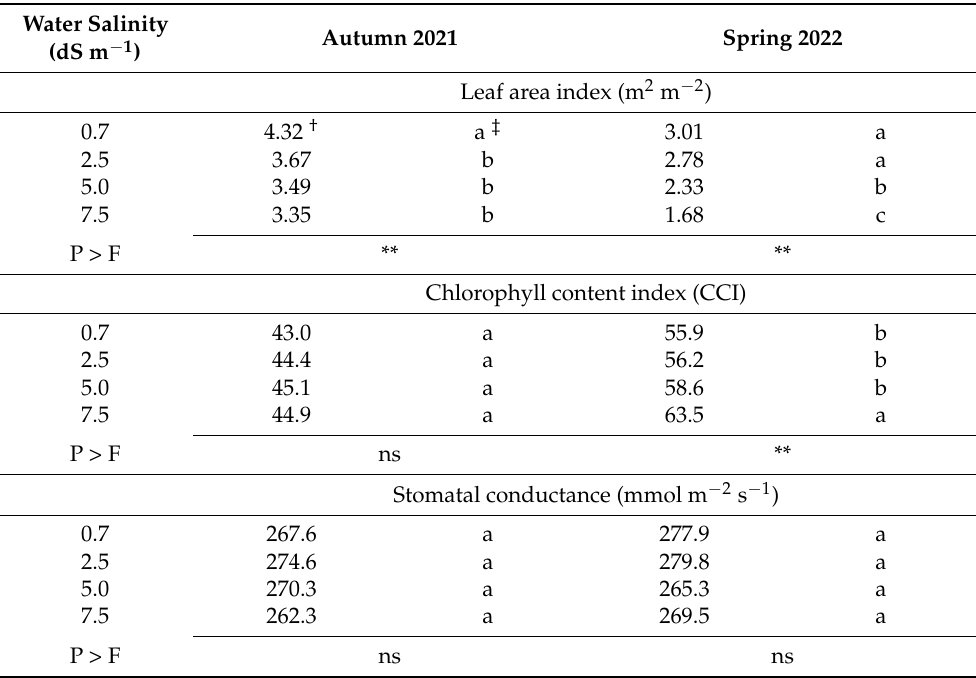
Table 5. The effect of irrigation water salinity on the seasonal averaged leaf area index, chlorophyll content index, and stomatal conductance